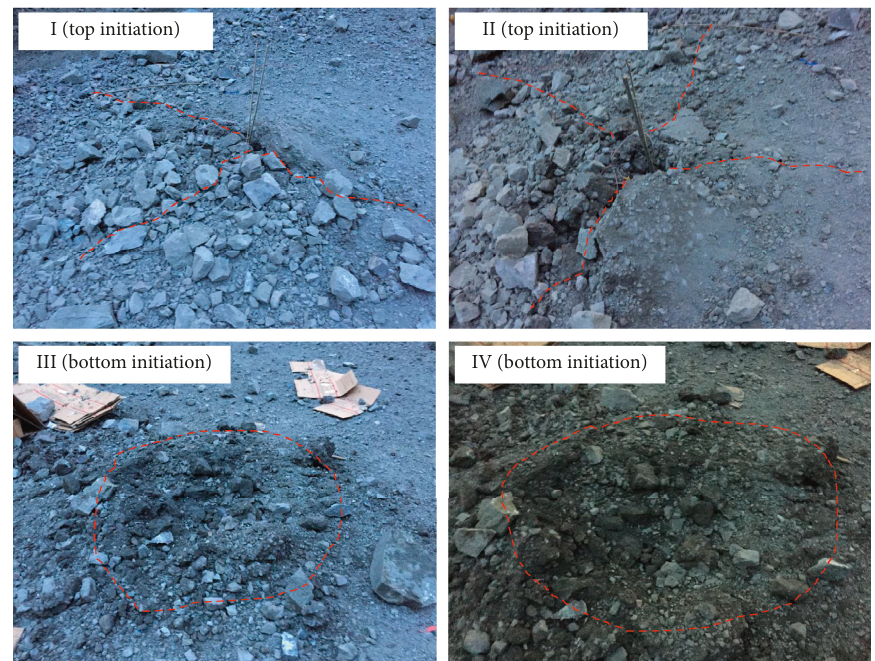
Figure 19: Pictures of rock mass after blasting in the single-hole blasting